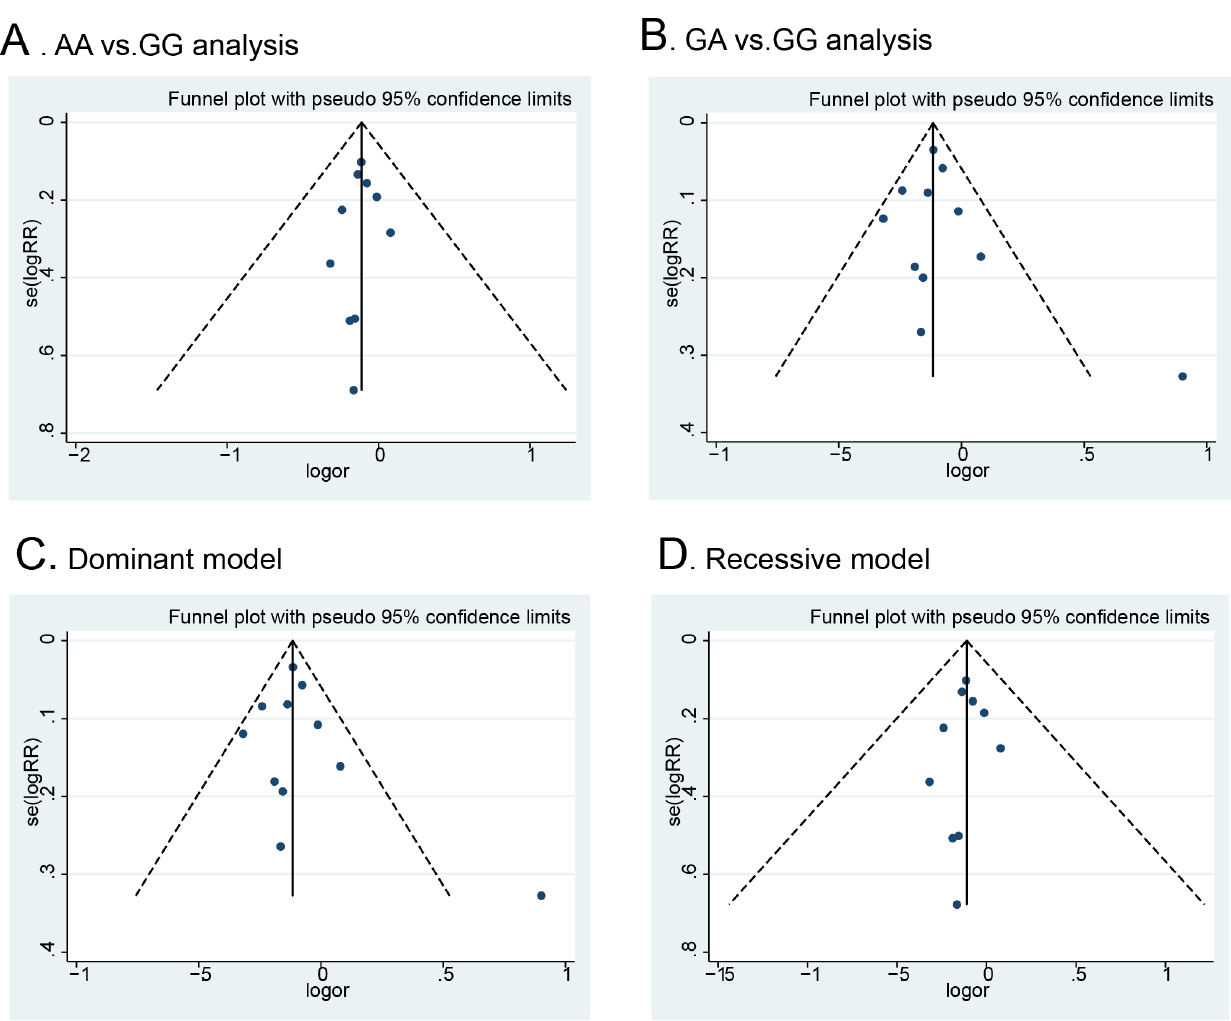
Figure 5. Funnel plot of ALDH2 Glu487Lys polymorphism and colorectal cancer risk for publication bias. doi:10.1371/journal.pone.0088656.g005 PLOS ONE |